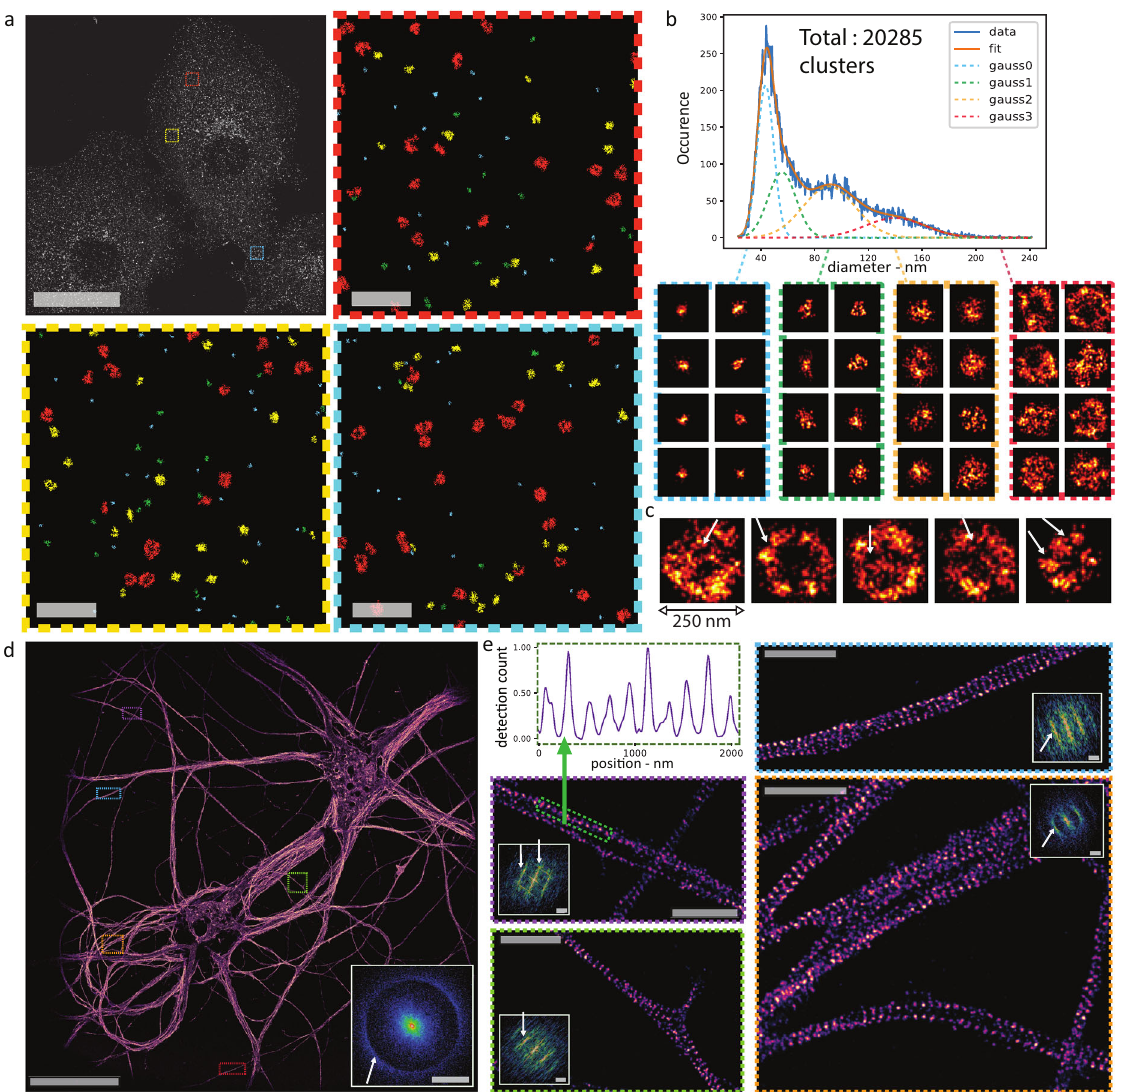
Fig. 5 ASTER applications for single-molecule localization microscopy. a – c ASTER STORM imaging and cluster analysis of COS-7 cells labeled for clathrin heavy-chain and an AF647-coupled secondary antibody. a Final 140 µ m × 140 µ m image with scalebar 40 µ m (top left) and close-up views of the highlighted regions (colors encode cluster af fi liation) with scalebars 1 µ m. Pixel size is 10 nm. b shows the distribution of the diameter of clathrin clusters and highlights four potential populations, that can be fi tted with Gaussian functions. Below are 250 nm × 250 nm images of individual clathrin related clusters, each group corresponding to a speci fi c population. c shows 250 nm × 250 nm images of large, hollow clathrin clusters likely corresponding to large clathrin-coated pits. Visible cavities are highlighted by arrows. d , e ASTER STORM imaging and structural analysis of neurons labeled for β 2-spectrin and AF647-coupled secondary antibody. d 200 µ m × 200 µ m STORM image obtained with ASTER (30 nm pixel size). Scalebar 40 µ m. The two- dimensional Fourier transformation (inset) exhibits a circular frequency pattern corresponding to a ~190 nm periodicity of the staining that is present along all axons. e Zoomed views of regions in d revealing the periodic cytoskeleton along single axons (pixel size is 10 nm). Upper left image shows the intensity pro fi le along the highlighted green line, revealing again the 190 nm periodicity. Scalebars 2 µ m. For d , e , insets show the respective two-dimensional Fourier transformation and the known 190 nm periodicity of the axonal spectrin scaffold is highlighted by arrows. All Fourier images scalebars are 4 µ m − 1